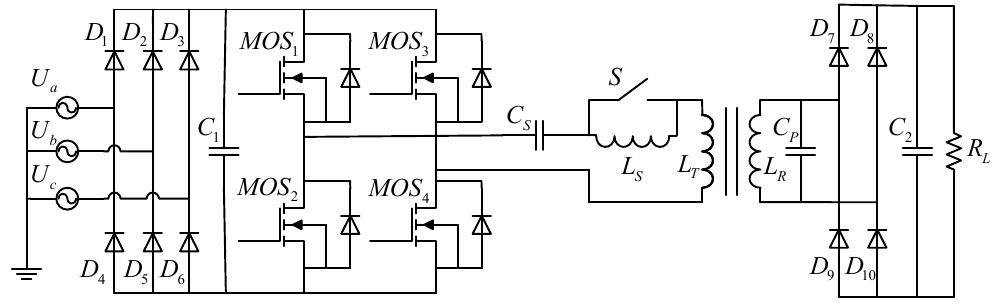
Figure 9. High-power wireless charging circuit of electric vehicles with SP compensation.